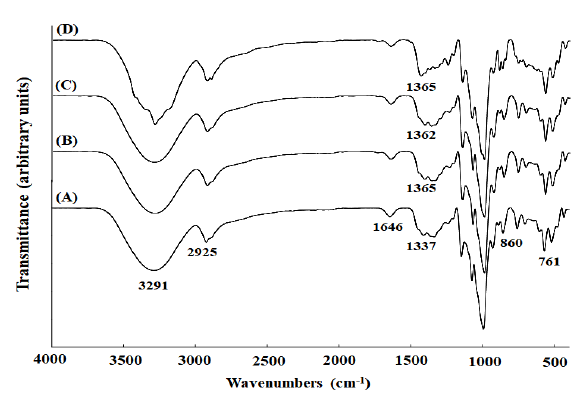
Figure 2. FT-IR spectra of GBS films containing CZEO. ( a ) GBS-C, ( b ) GBS-0.1, ( c ) GBS-0.3, ( d )